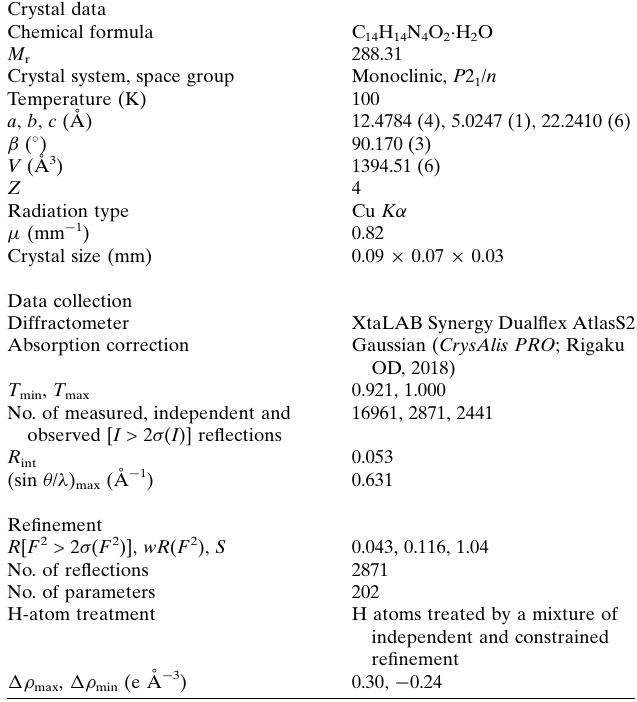
Table 6 Experimental details. Crystal data Chemical